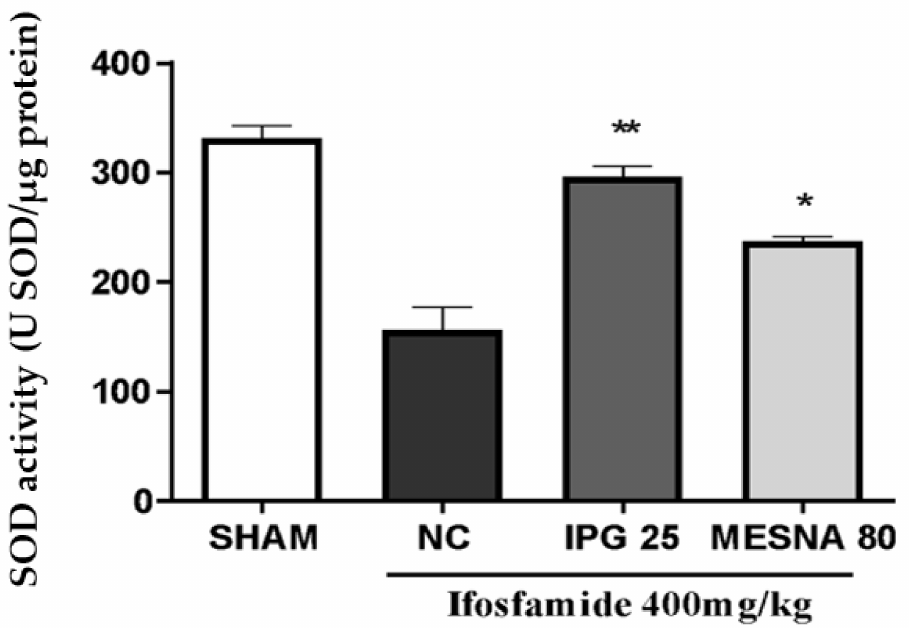
Figure 7. Effect of IPG on superoxide dismutase (SOD) levels in the bladder tissue of animals with ifosfamide-induced hemorrhagic cystitis. Data are expressed in U of SOD per µ g of protein, as mean ± SEM ( n = 6). Data were compared with the negative control (NC, Tween/saline) by one-way analysis of variance (ANOVA), followed by the Bonferroni test; * p < 0.05, ** p <